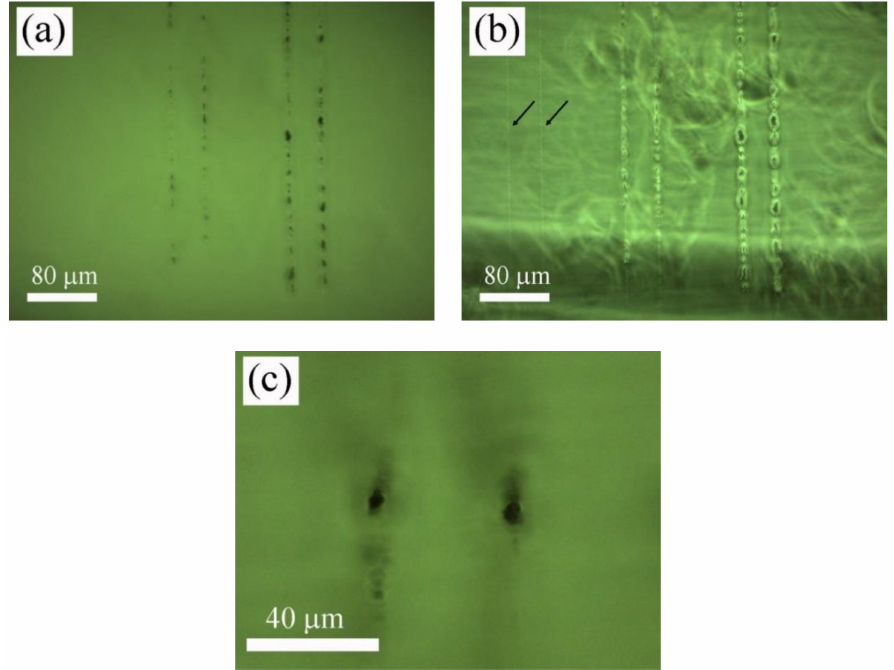
Figure 4. Top-view microscope images in bright field and contrast phase mode, ( a , b ) respectively, of the tracks written inside the sample with the laser oscillator at 400 nm as a function of the laser intensity by translating the sample at 0.25 mm / s. Arrows in ( b ) points out tracks written at 0.19 nJ. ( c ) shows a cross-section-view microscope image in bright field mode of the tracks structured at 0.38 nJ and 0.25 mm /